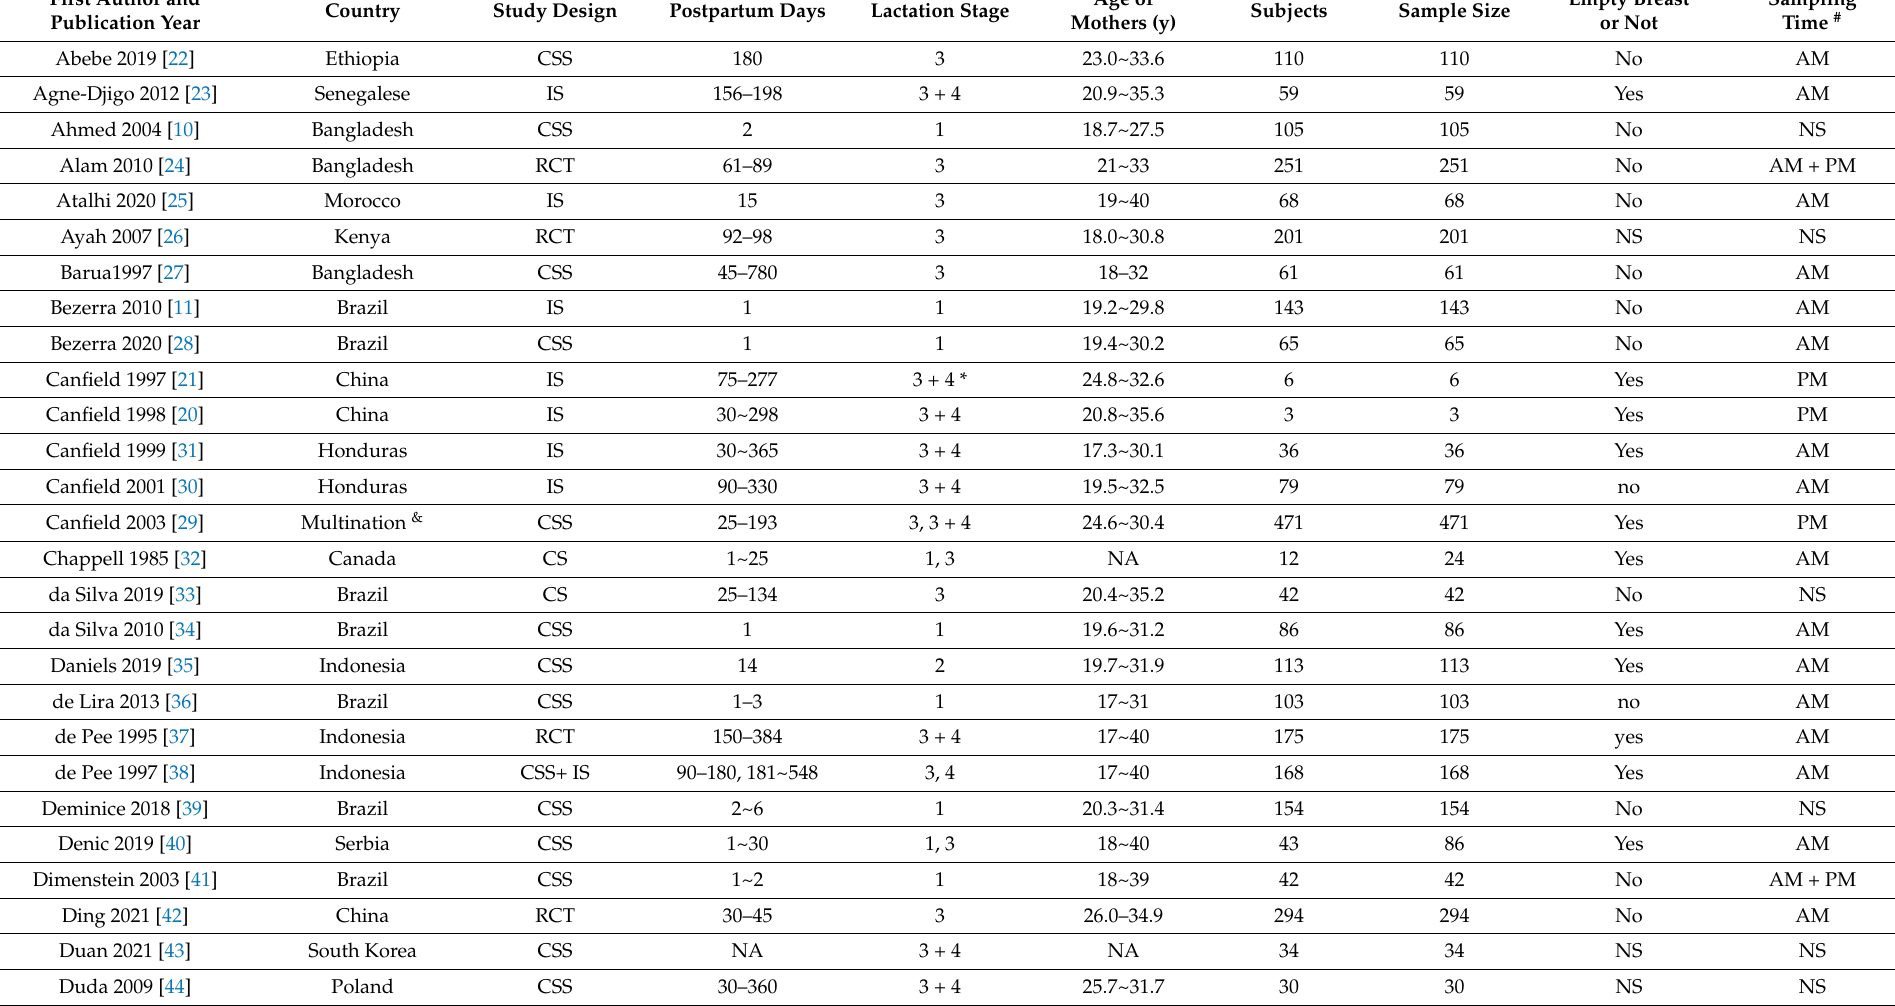
Table 1. Summary Characteristics of included